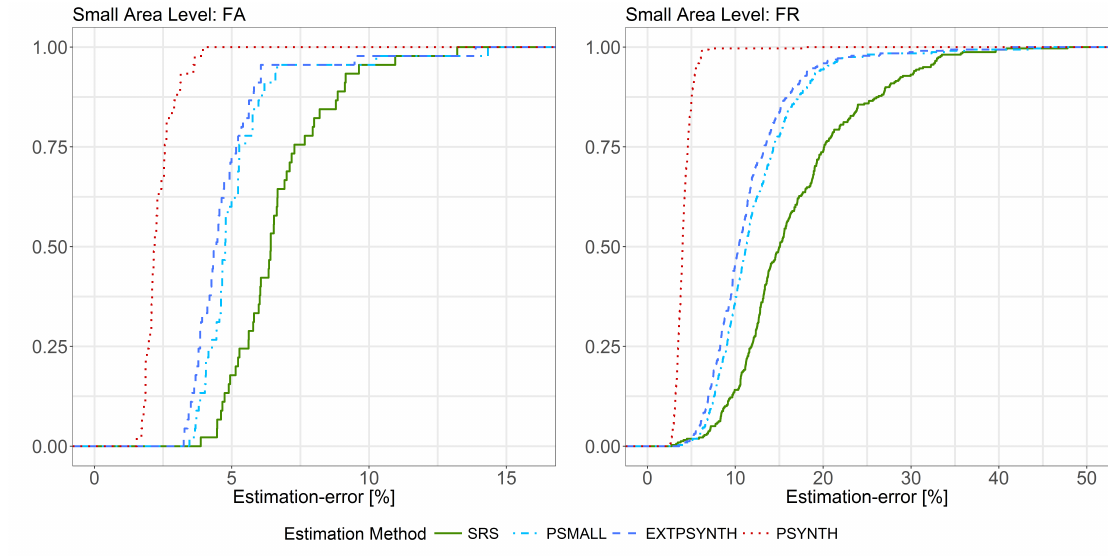
Figure 3. Cumulative distribution of estimation errors under SRS, PSMALL, EXTPSYNTH and the PSYNTH estimator. ( Left ): Results for the 45 FA units. ( Right ): Results for the 321 FR